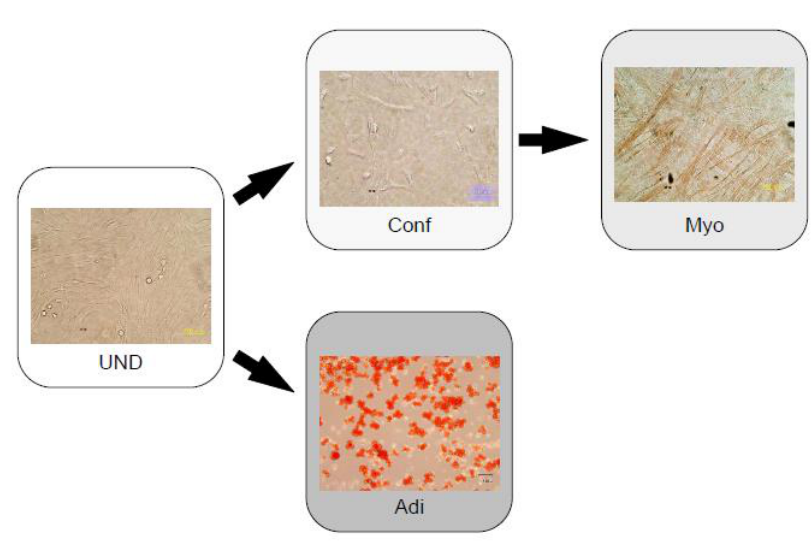
Figure 1. Left-atrium-derived pluripotent-like cells (LA-PCs) contain stem cells and progenitors of skeletal/cardiac myocytes (Myo) or adipocytes (Adi). Differentiated Myo was troponin I positive, and differentiated Adi was positively stained by oil red. The figure is reproduced from reference [71] with